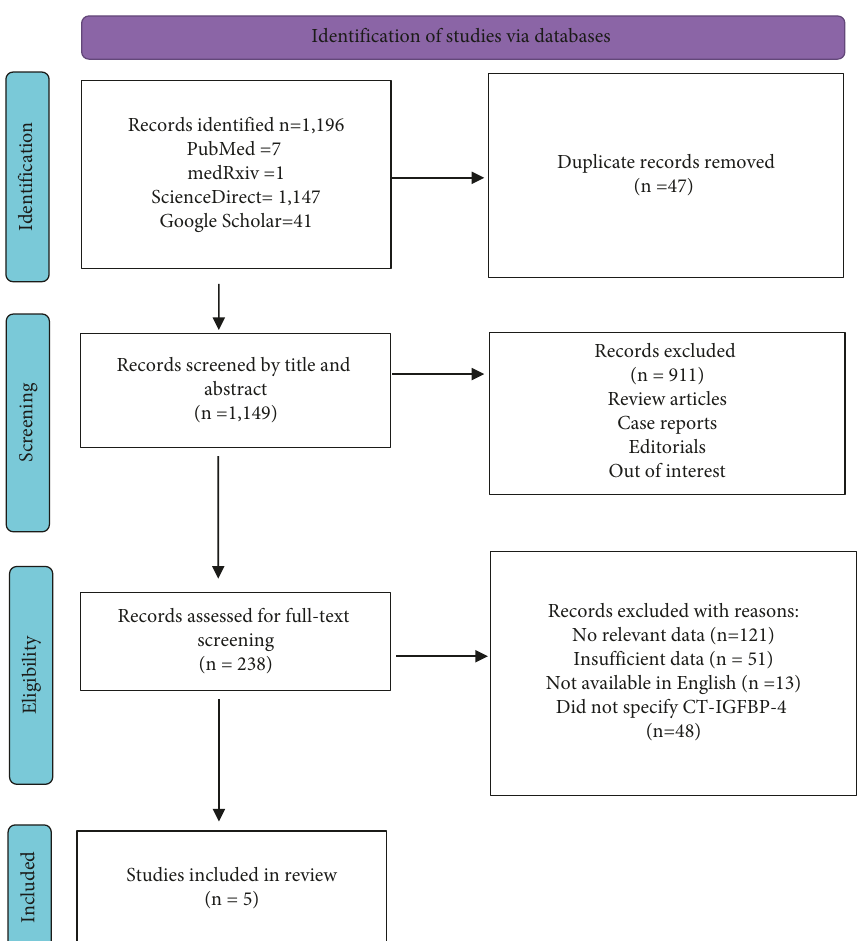
Figure 2: Preferred reporting items for systematic reviews and meta-analyses (PRISMA) flowchart for study